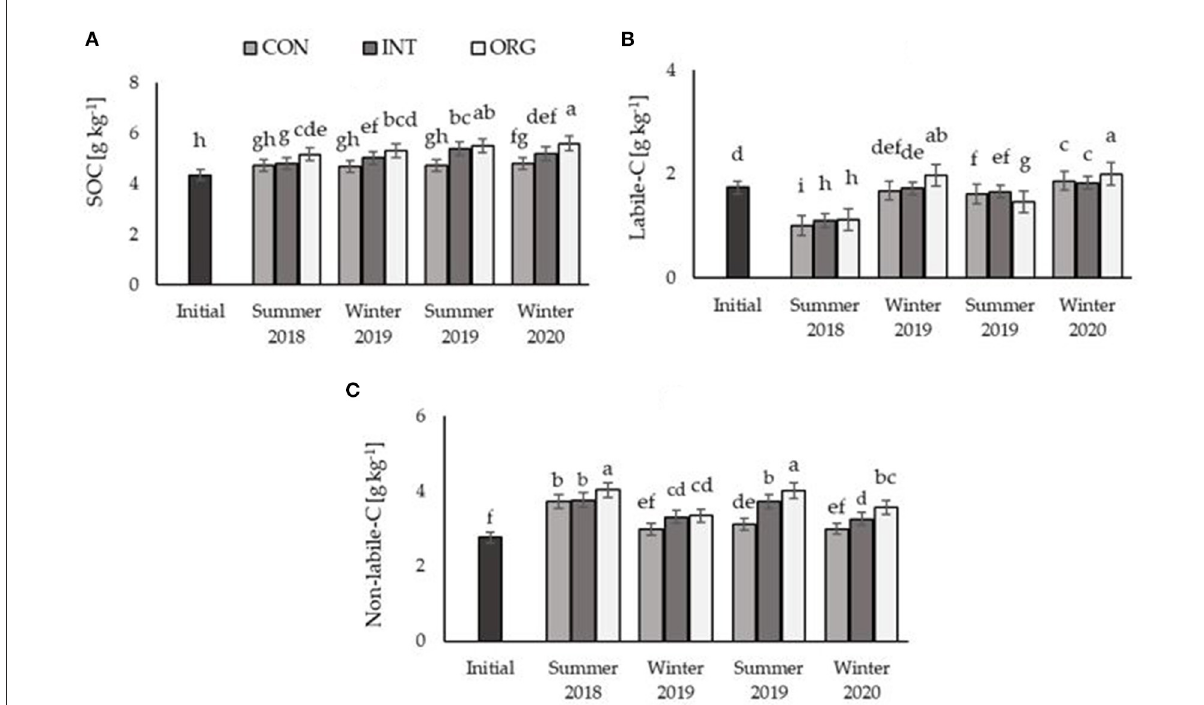
FIGURE2 Effects of four seasonal weather variations and three agricultural strategies (conventional, CON; organic, ORG; and integrated management strategy, INT) on (A) soil organic carbon (SOC), (B) labile-C, and (C) non-labile-C content. The initial bar indicates the measured values at the start of the experiment. The x -axis depict the time of sampling after the harvest of the respective crops. Letters indicate significant difference at p ≤ 0.05 according to Duncan’s multiple range test. Identical letters indicate no significant difference between the